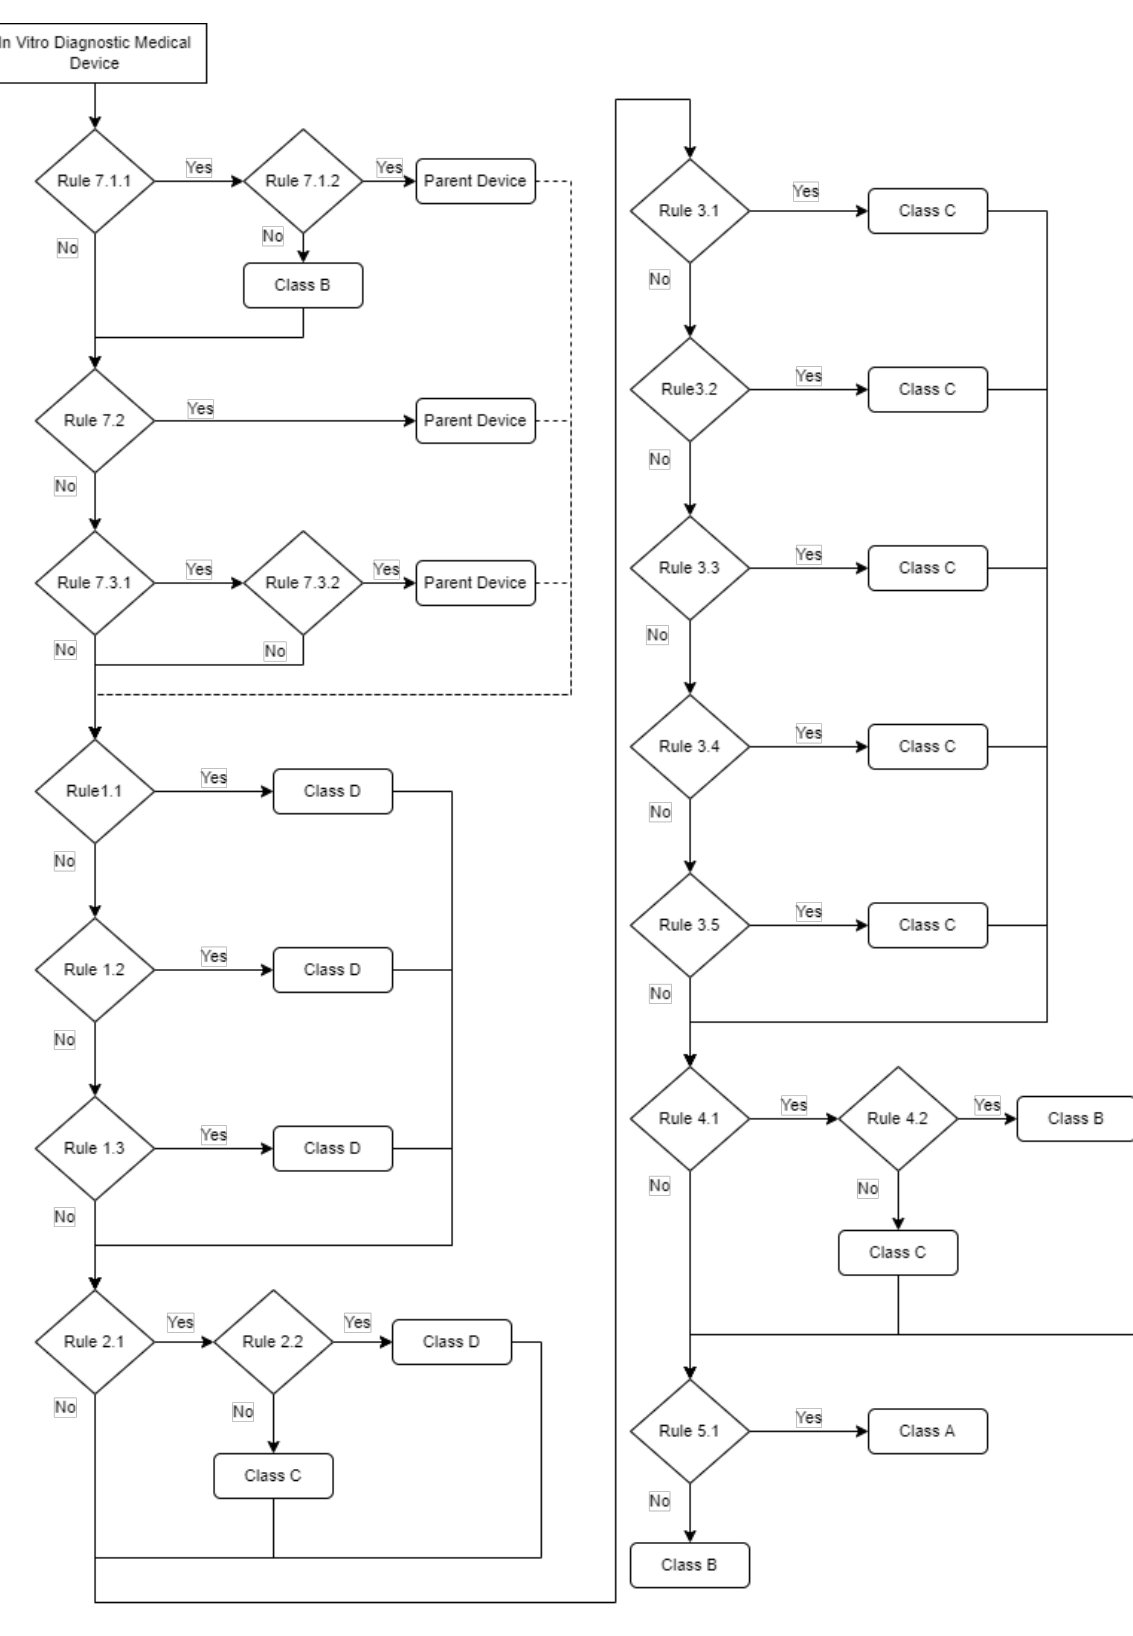
Figure 3 . IVDR Decision Tree with Rules, classification rules and device risks corresponding to the IVDR Classification Rules and criteria in Table 2. The final classification given to a device consisted of Class A, B, C or D.